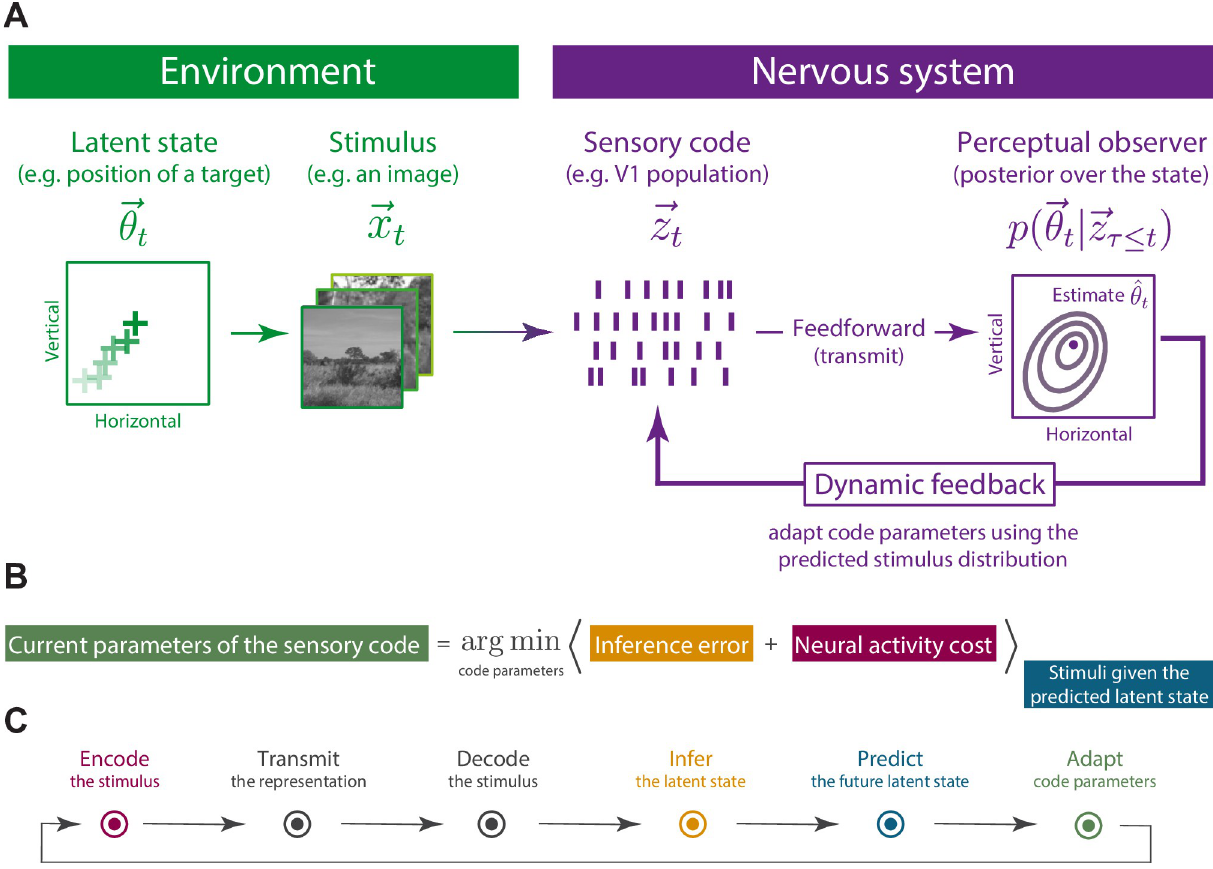
! gives t . The properties of sensory neurons (e.g., t ! . A sensory t ! with its internal model of the t ! ! j z Þ . The t � t t , and t ! ! j z Þ . Based on this t � t t þ 1